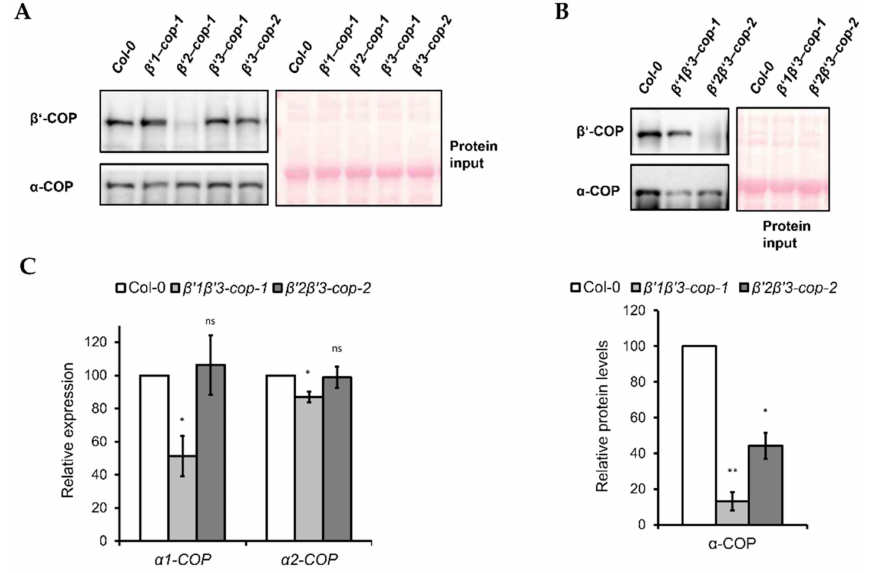
Figure 5. Expression levels of coatomer subunit α -COPI in β ’1 β ’3-cop -1 and β ’2 β ’3-cop-2 mutants. ( A ) Western blot analysis of cytosol protein extracts from cotyledon of 7-day-old seedlings of wild type, β ’1-cop-1 , β ’2-cop-1 , β ’3-cop-1 and β ’3-cop-2 mutants using mammalian β ’-COP and α -COP N-terminal peptide antibodies [48,49]. β ’1-COP antibodies were raised against the first 12 amino acids of cow β ’1-COP. Cow β ’-COP and Arabidopsis β ’1-COP, β ’2-COP and β ’3-COP share 10, 11 and 10 amino acids, respectively. The β ’-COP antibody detected a clear band of approximately 100 kDa, corresponding to the molecular weight of β ’-COP, in wild type (Col-0), β ’1-cop-1 , β ’3-cop-1 and β ’3- cop-2 , and only a faint band in β ’2-cop-1 , suggesting that mammalian β ’-COP antibody has higher affinity for β ’2-COP. The different affinity for β ’2-COP could be due to the sixth N-terminal amino acid of β ’2-COP that is the same in of cow β ’-COP and not in β ’1-COP and β ’3-COP. Alternatively, different splicing forms involved or postranslational modifications at the N-terminal might decrease the affinity of the antibody. α -COP antibodies have been previously shown to recognize both α 1-COP and α 2-COP isoforms and detected a band of approximately 130 kDa corresponding to the molecular weight of α -COP [30]. ( B ) Western blot analysis of cytosolic protein extracts from cotyledon of 7-day-old seedlings of wild type, β ’1 β ’3-cop-1 and β ’2 β ’3-cop-2 using mammalian β ’-COP and α -COP N-terminal peptide antibodies. The β ’-COP antibody recognized a clear band of approximately 100 kDa in β ’1 β ’3-cop-1 and a faint band in β ’2 β ’3-cop-2 , suggesting again that mammalian β ’-COP antibody has higher affinity for β ’2-COP. Bottom panel shows the relative α -COP protein levels quantified of three biological samples. In ( A , B ), 12 µ g of total protein was loaded in each lane. Ponceau protein stain was used as a loading control. ( C ) Relative expression levels of α -COP genes. Total RNA was isolated from 7-day-old cotyledon seedlings of wild type, β ’1 β ’3-cop-1 and β ’2 β ’3- cop-2 mutants. RT-sqPCR analysis was performed with the primers listed in Supplementary Table S2. ACT7 was used as a control. Values represent mean ± s.e.m. of the three biological samples and were normalized against the band intensity in wild type that was considered to be 100%. Statistical significance: ns, not significant; * p < 0.05; ** p <